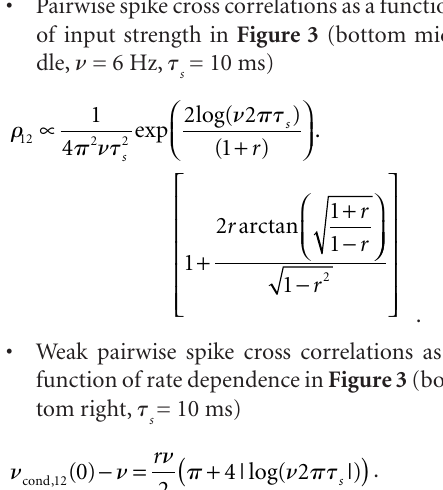
Figure 3 | Pairwise spike correlations in the novel threshold model framework. The spike times neurons t and the corresponding spike trains s − t 1 3 represented by rectangles in red (top) or blue (center) are modeled in the threshold framework by positive threshold crossings (black dashed line) of a fluctuating potential V or V ( t ), respectively. The correlations between neurons are 2